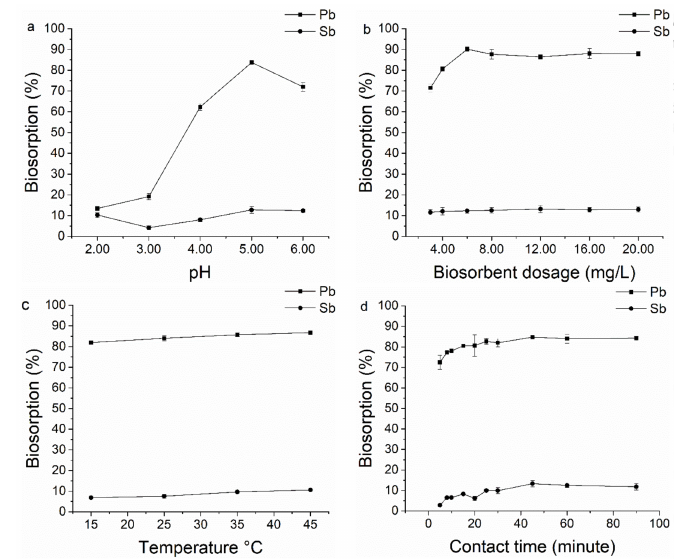
Figure 1. Effect of pH ( a ) metal concentration: 25.00 mg/L; temperature: 25 ◦ C; biomass dosage ( b ) metal concentration: 25.00 mg/L; pH: 5.0, temperature: 25 ◦ C; temperature ( c ) metal concentration: 25.00 mg/L; pH: 5.0, biomass dosage: 6.00 mg/L; and contact time ( d ) metal concentration: 25.00 mg/L; pH: 5.0, biomass dosage: 6.00 mg/L, temperature: 35 ◦ C; on the biosorption of Pb(II) and Sb(III)